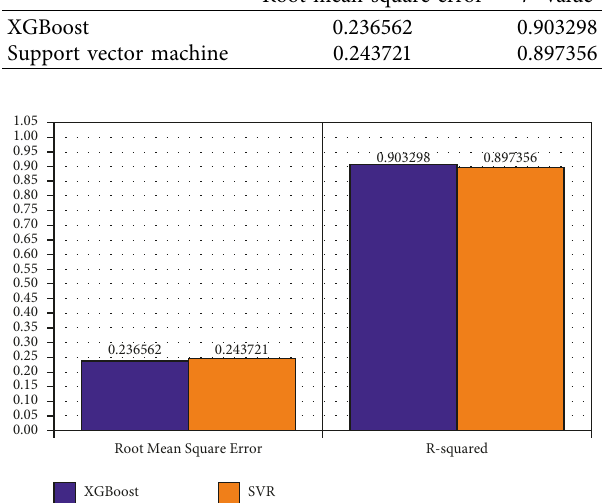
Figure 13: A plot of LIME model values for the XGBoost model and Aus yield data.